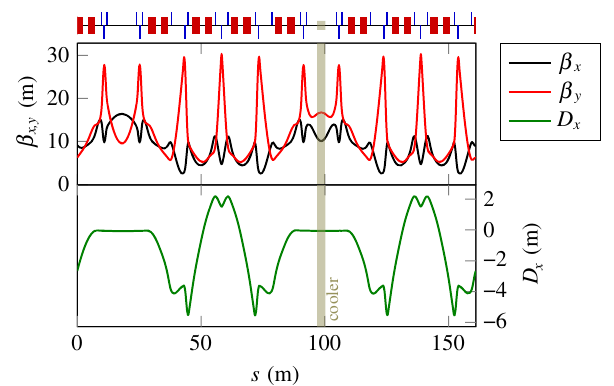
FIG. 1. MAD-X [12] simulation of the optical functions of the CSRm ring.